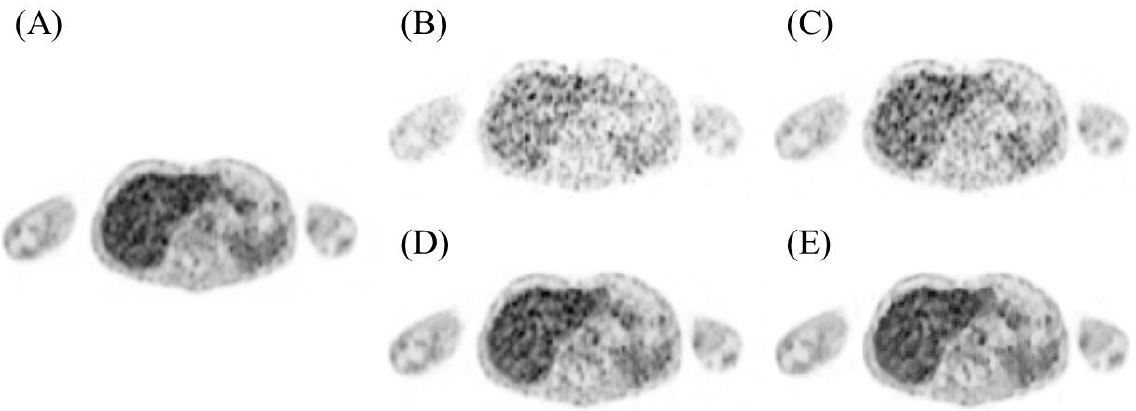
Figure 2. Representative images at liver level. ( A ) Original “ground-truth” image, ( B ) 10% PET image, ( C ) 20% PET image, ( D ) 50% PET image, and ( E ) super-resolved image obtained via a residual dense network from the 50% PET image.